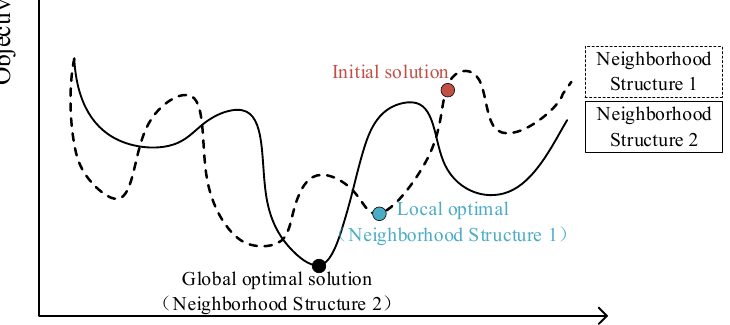
Figure 4. Illustration of the local search process.